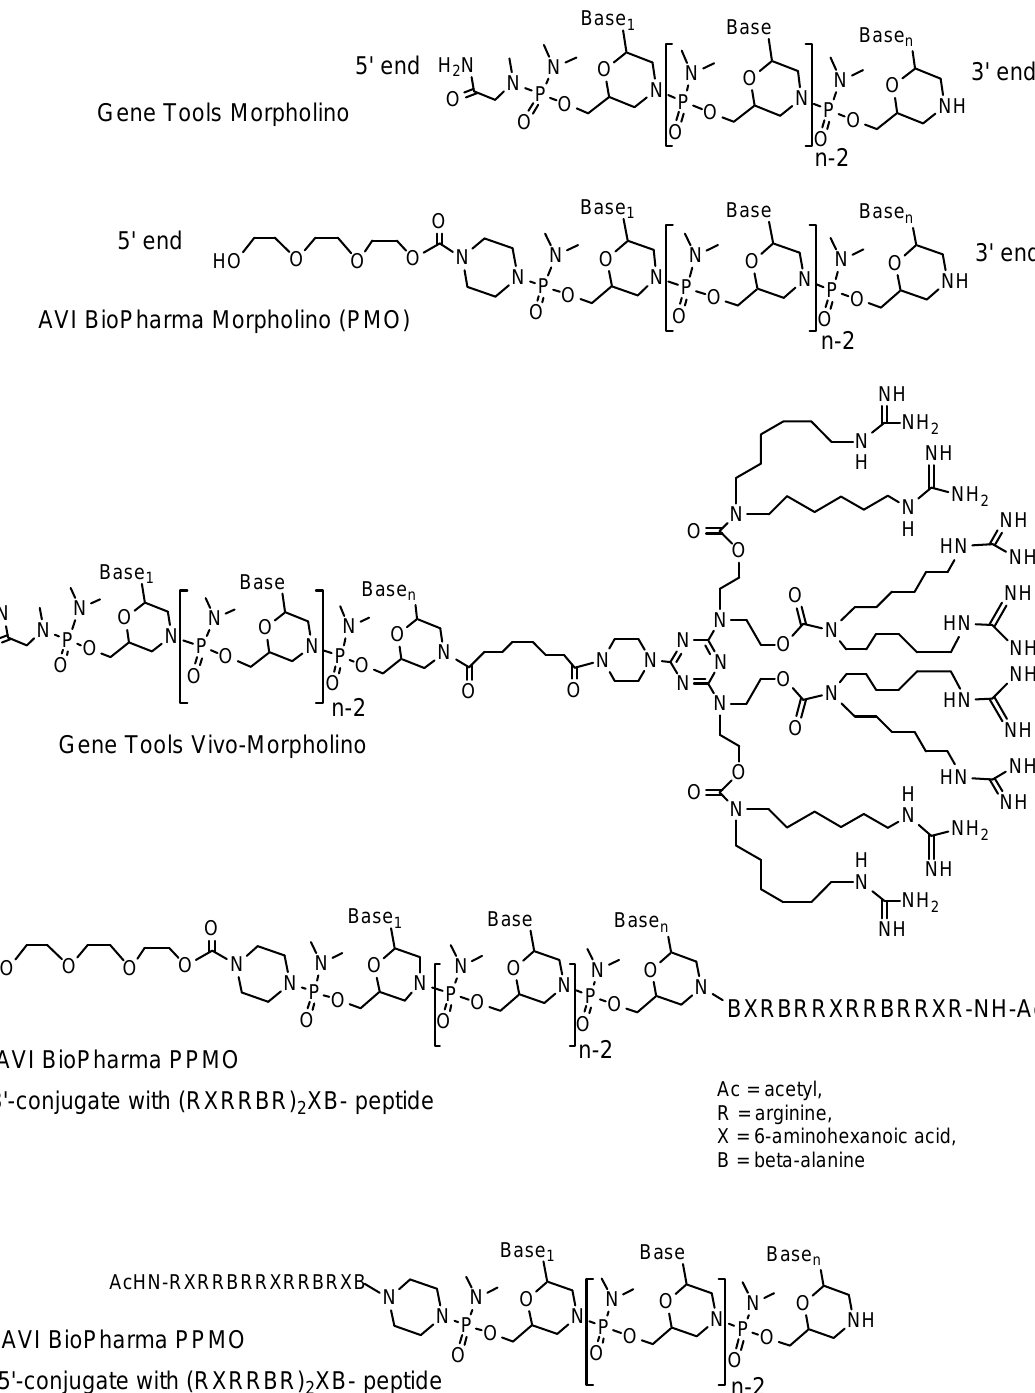
Figure 1. Structures of unmodified and delivery-enabled Morpholino